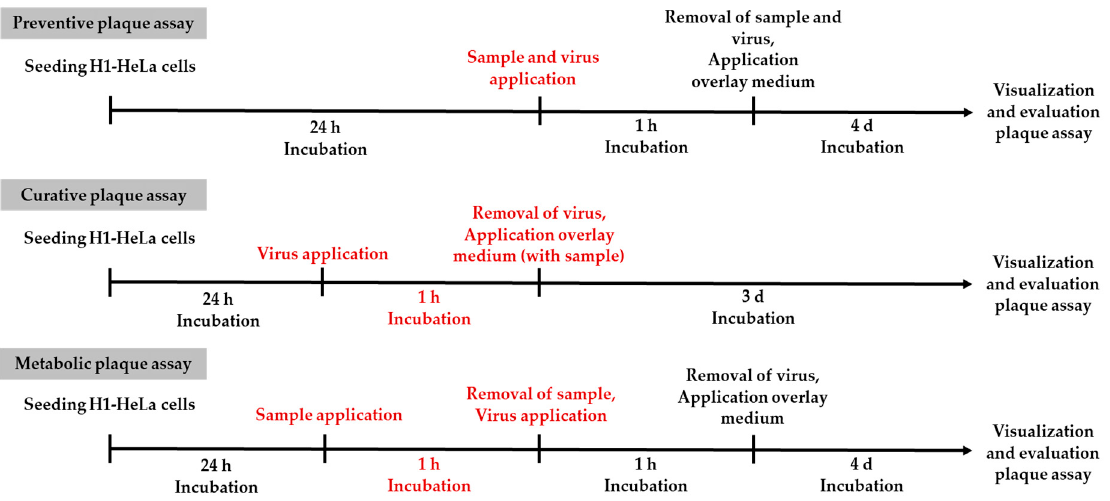
ff erent plaque assays performed in this Figure 1. Overview of the different plaque assays performed in this work. Figure 1. Overview of the di